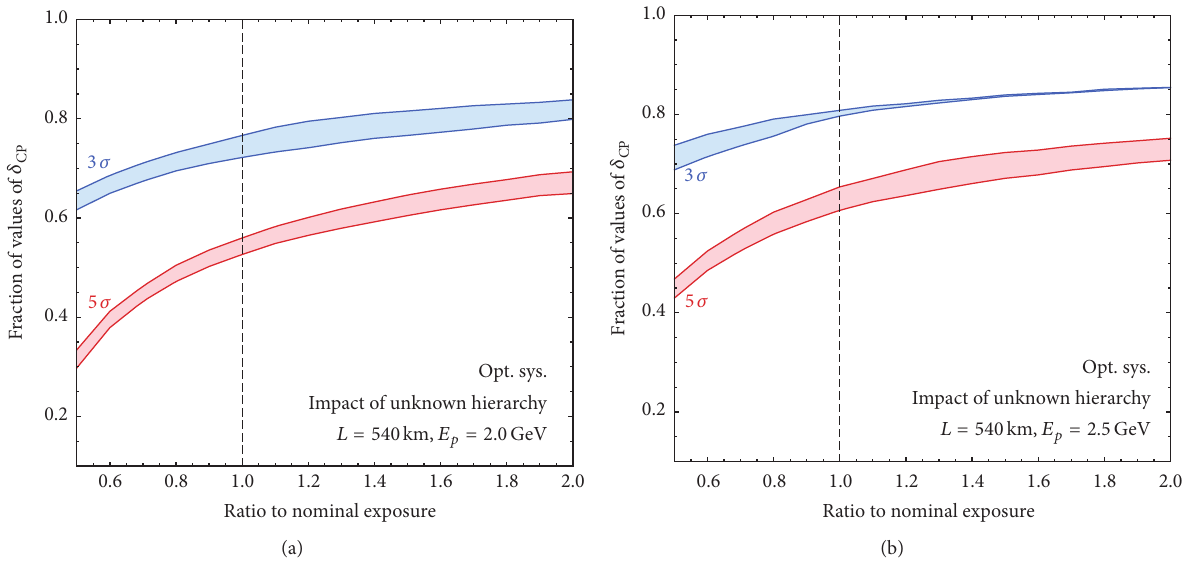
Figure 9: Curves showing the dependence of the fraction of values of 𝛿 CP for which a CP violation discovery at 5 𝜎 and 3 𝜎 , respectively, can be made as a function of event statistics, or exposure, where the nominal exposure corresponds to 10 years of data taking. (a) is for a proton energy of 2.0 GeV (current ESS design) and (b) for 2.5 GeV. The upper boundaries of the colored bands were obtained assuming the hierarchy to be known (NH) and the lower boundaries assuming the hierarchy to be unknown; that is, it is marginalized over. The systematic errors used to produce these plots are those shown in the right column (SB Opt.) of Table 3 [18].